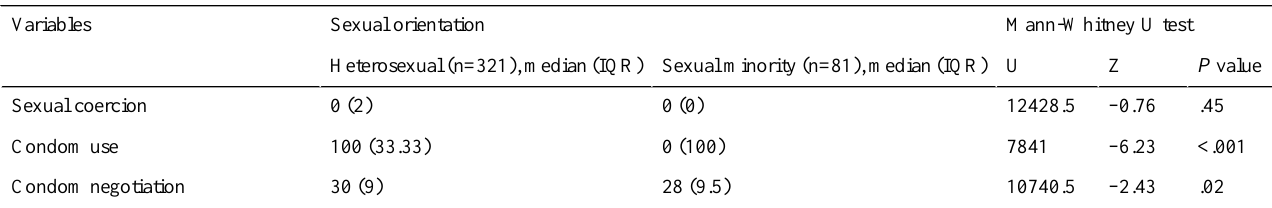
Table 1. Description of the study variables and results of the Mann-Whitney U